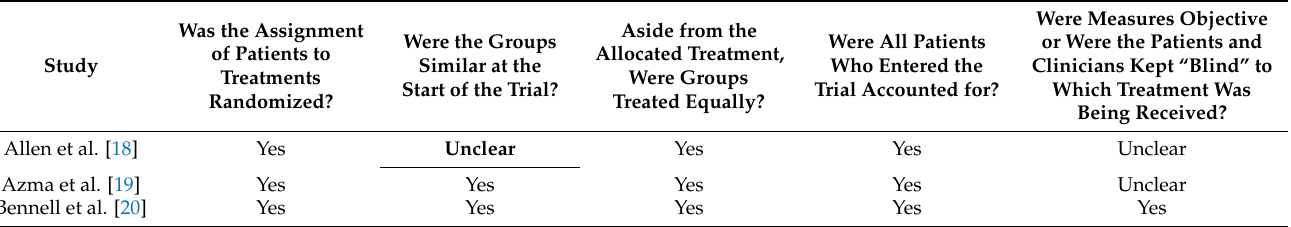
Table 3. Summary of the risk of bias within the three studies (screened for unbiased practices based on the 2005 Oxford standard [17].